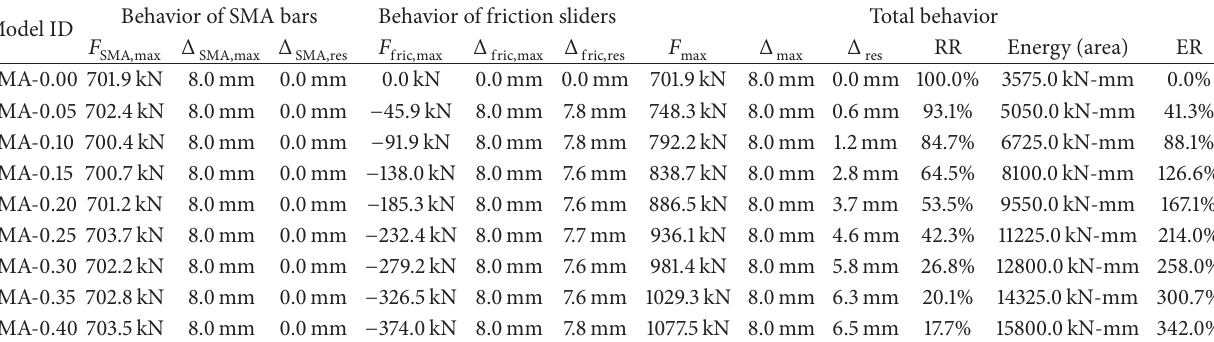
Table 2: Summarized analysis results for the SMA bearing